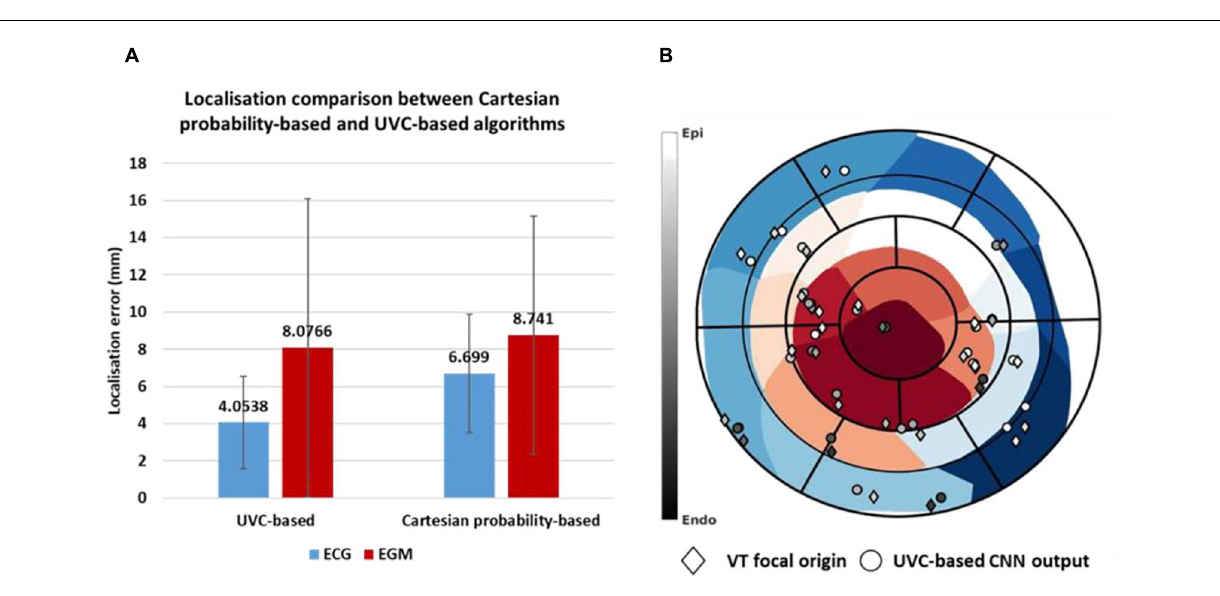
FIGURE 11 | Localization comparison between UVC-based and Cartesian probability-based algorithms. Mean localization errors (A) are reported in millimeters with corresponding standard deviations for ECG-based (blue) and EGM-based (red) testing. An example of how ventricular tachycardia ( VT) focal origins compare to UVC-based localized sources is shown in (B) ; diamonds represent the ground truths, whereas the circles are the CNN outputs. The gray color bar represents the distance from endocardial (black) to epicardial (white) surfaces of each source, whereas the blue-to-red color bar represents 1–17 patient-specific AHA